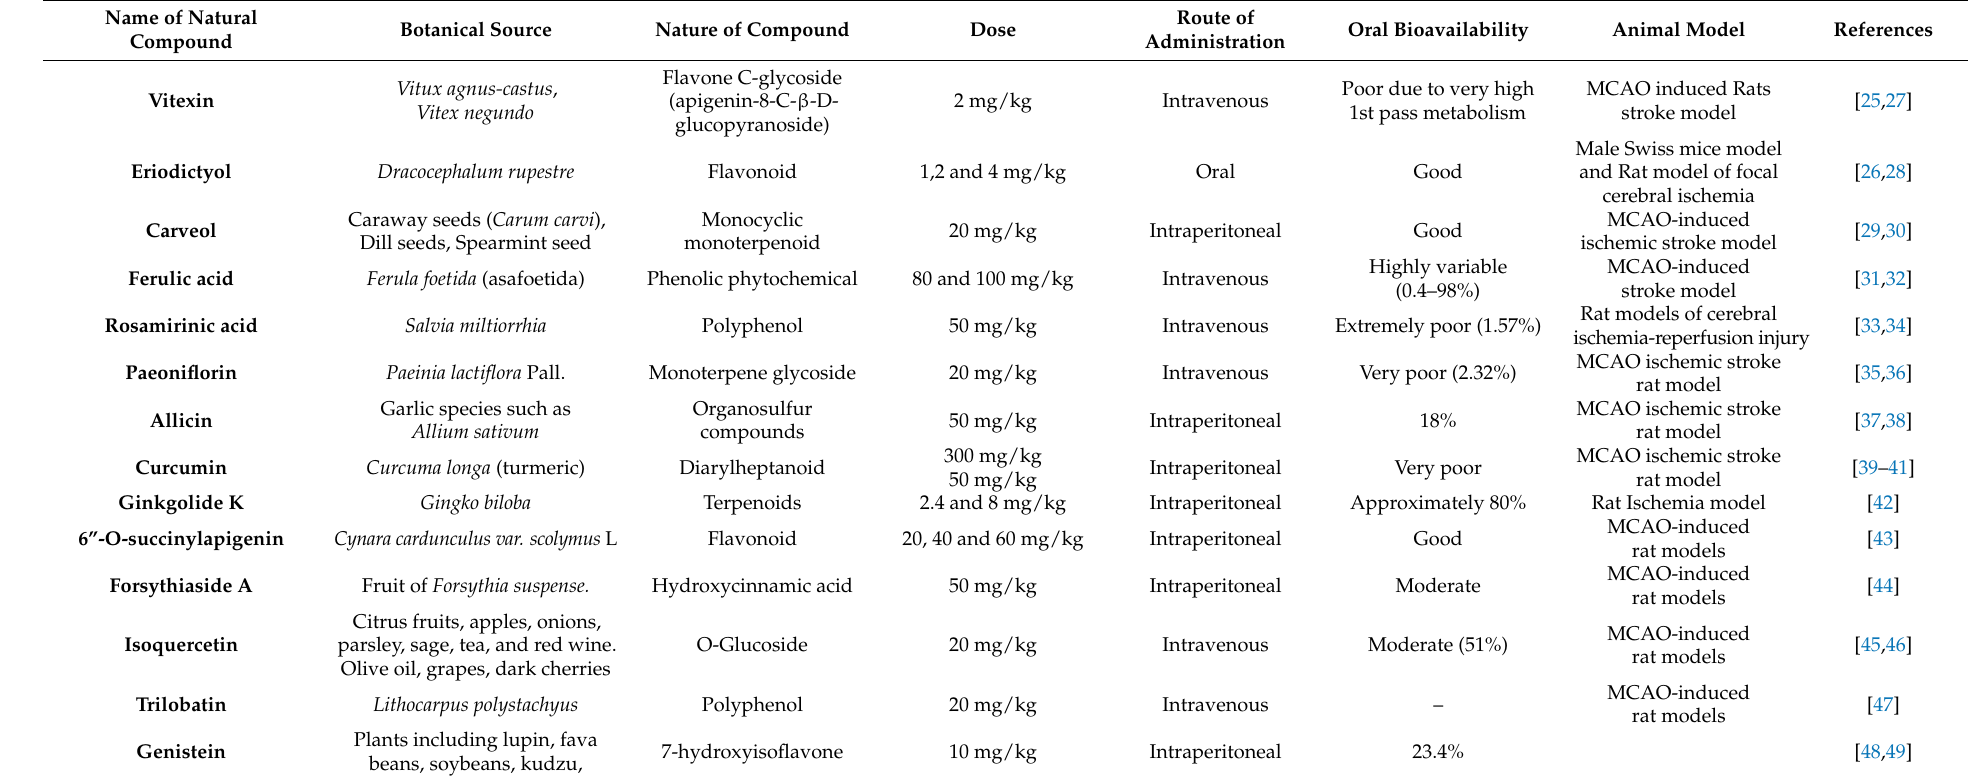
Table 1. Phytocompounds, their biological source, nature of the compound, the dose given to animal models, route of administration, oral bioavailability, and animal